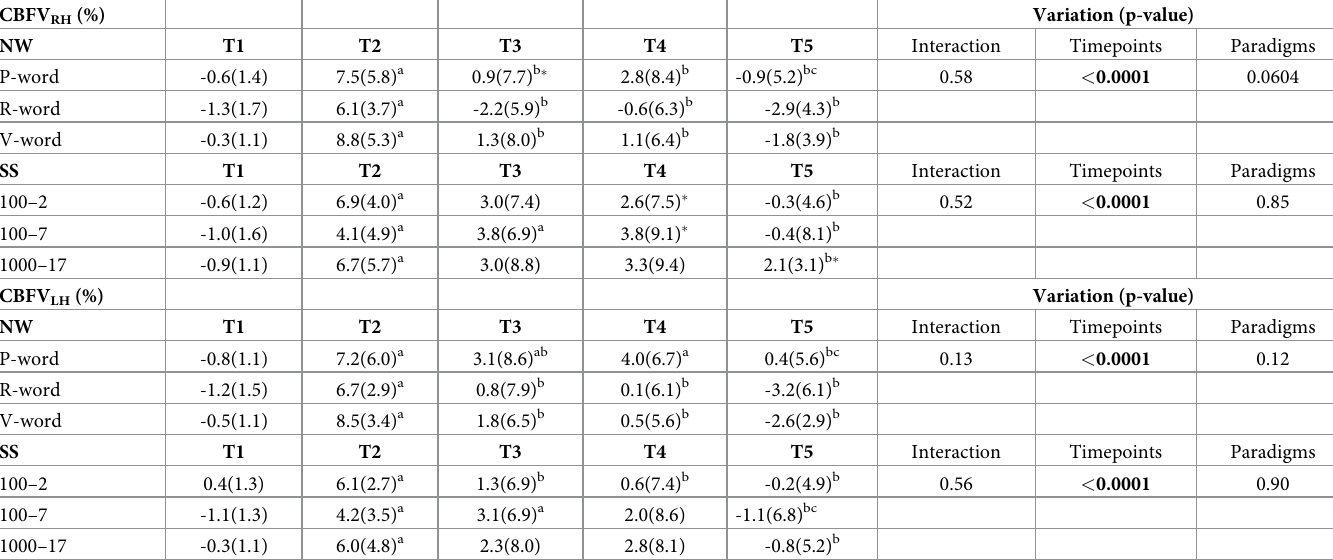
Table 1. Mean (SD) values of bilateral cerebral hemodynamic changes at each timepoint for increasing complexity of NW and SS paradigms.